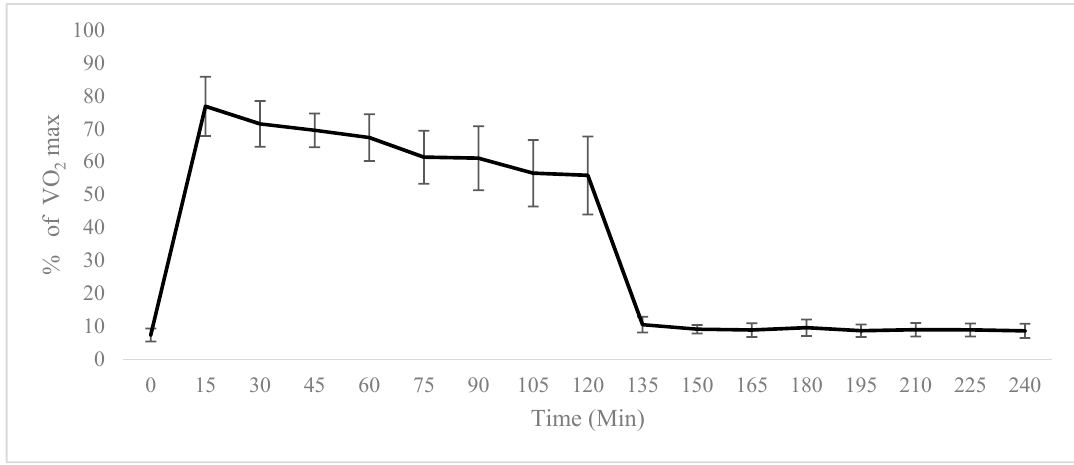
Figure 2. Average percentage of VO 2 max based on calculation from respired air collection every 15 min. This data shows that effort was well conserved at approximately 70% of VO 2 max for 60 min. Variation is seen across the time trail phase, with a general trend of slight reduction in effort. Variation increases towards the end of this section exercise phase, likely due to pacing differences in participants. Percentage of VO 2 max is well conserved across the rest phase, indicating a similar level of exertion for all participants.